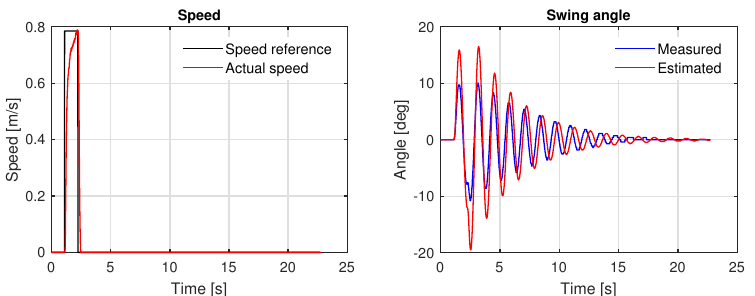
Figure 9. Speed reference and the actual speed ( left ) and the measured and estimated swing angles ( right ) when no control is applied.